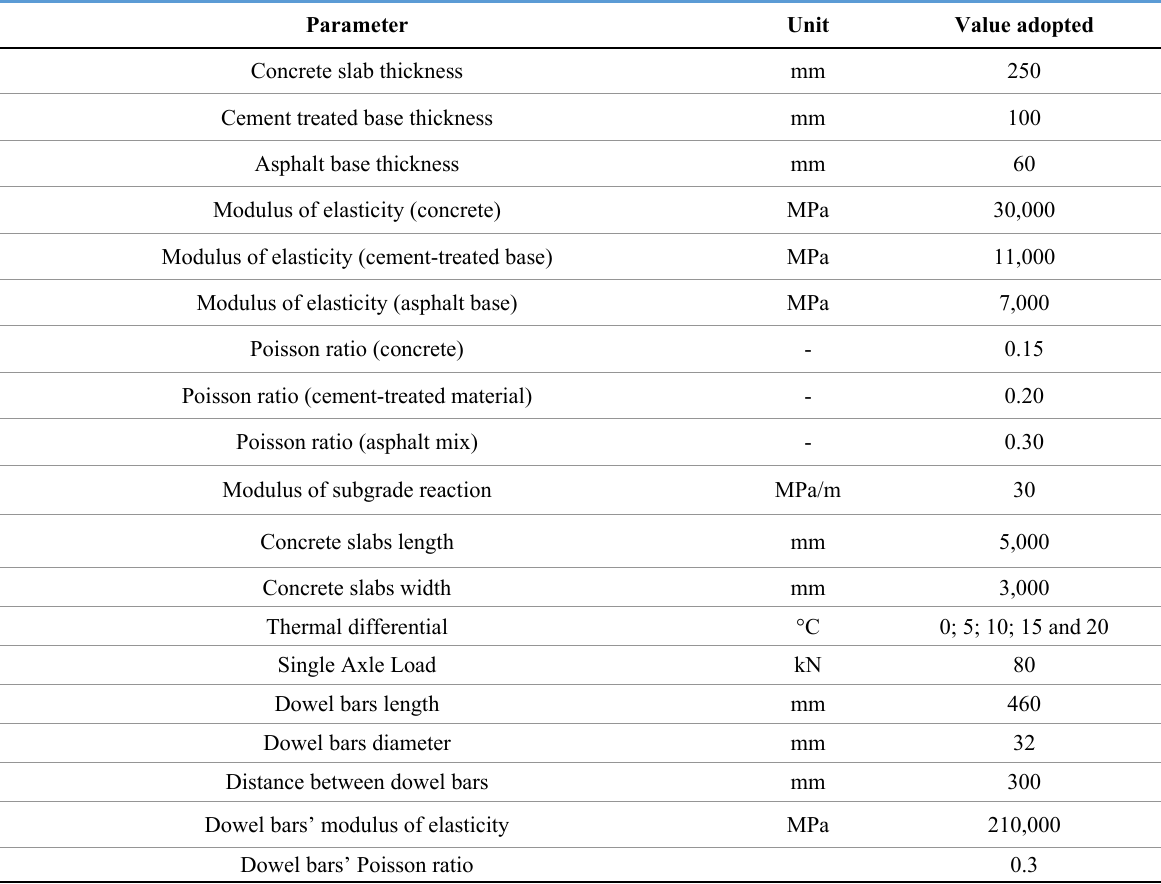
Table 2. Parameters and values adopted for numerical